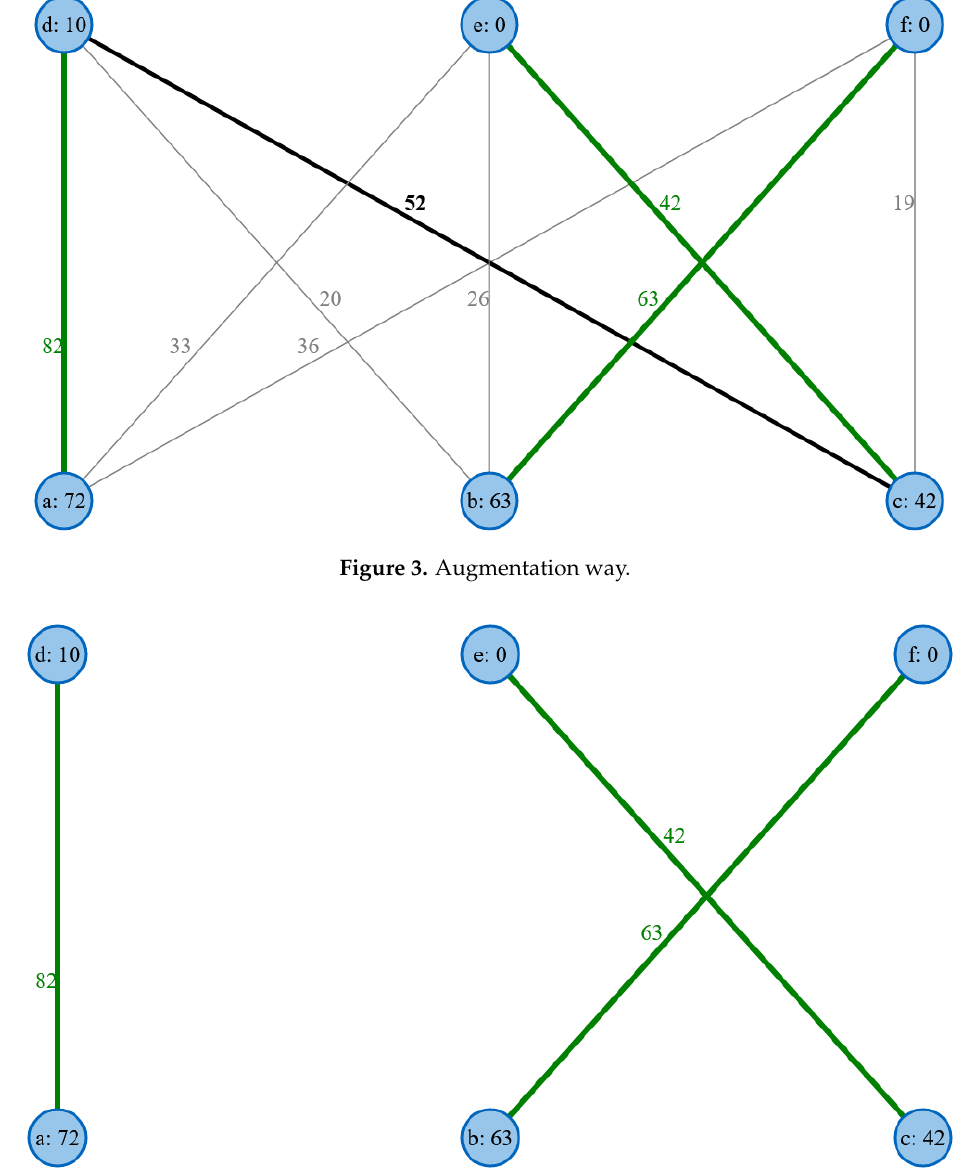
Figure 4. Optimal matching.